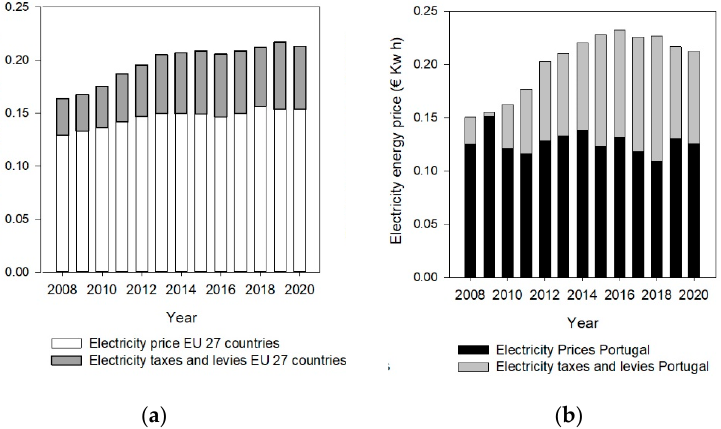
Figure 9. Median equivalized net income by household for EU and Portugal (data source [73]).